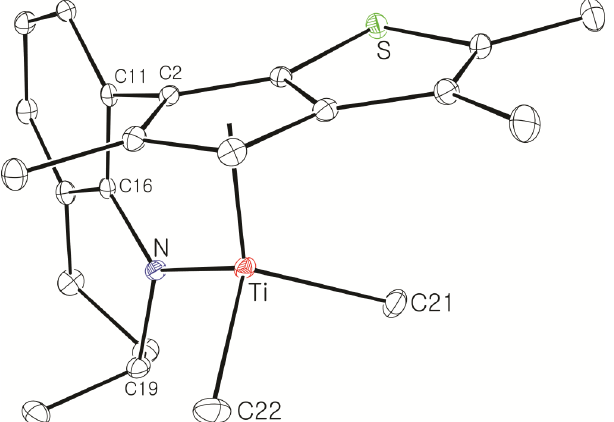
Figure 3. Thermal ellipsoid plot (30% probability level) of 27 . Hydrogen atoms are omitted for